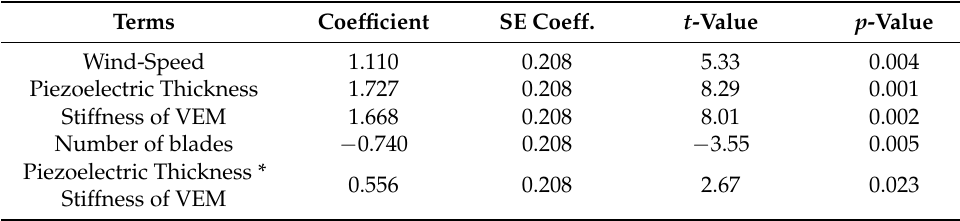
Table 3. Input variables of proposed energy harvester used in